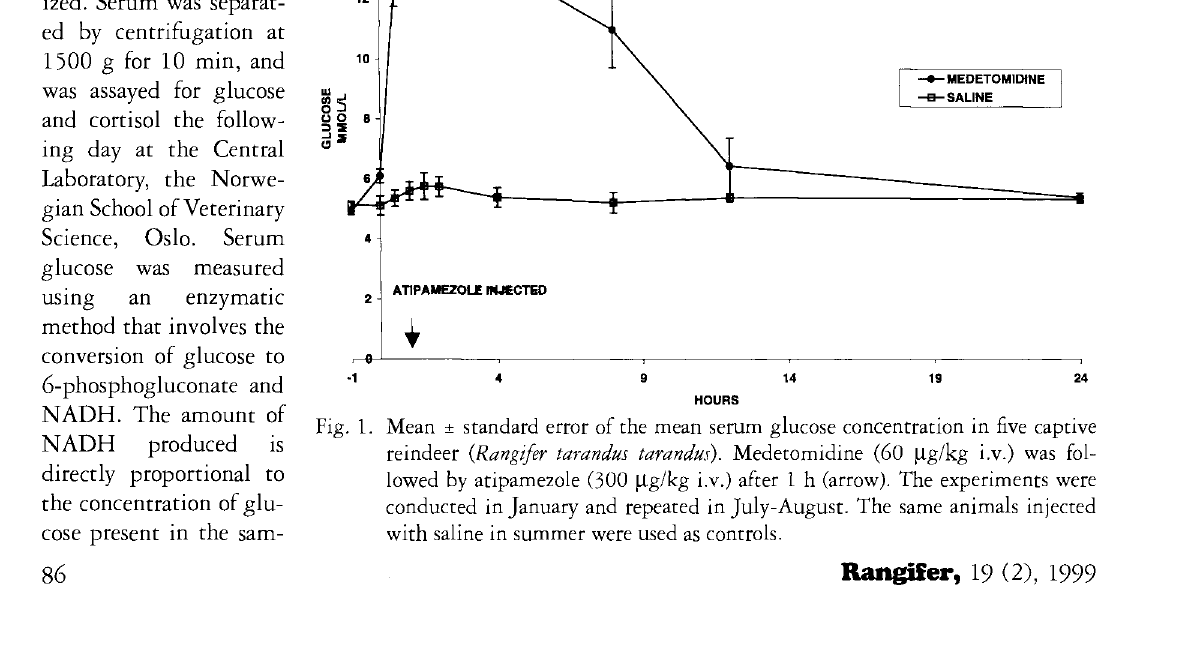
Fig. 1. Mean ± standard error of the mean serum glucose concentration in five captive reindeer (Rangifer tarandus tarandus). Medetomidine (60 Hg/kg i.v.) was fol lowed by atipamezole (300 |-lg/kg i.v.) after 1 h (arrow). The experiments were conducted in January and repeated in July-August. The same animals injected with saline in summer were used as